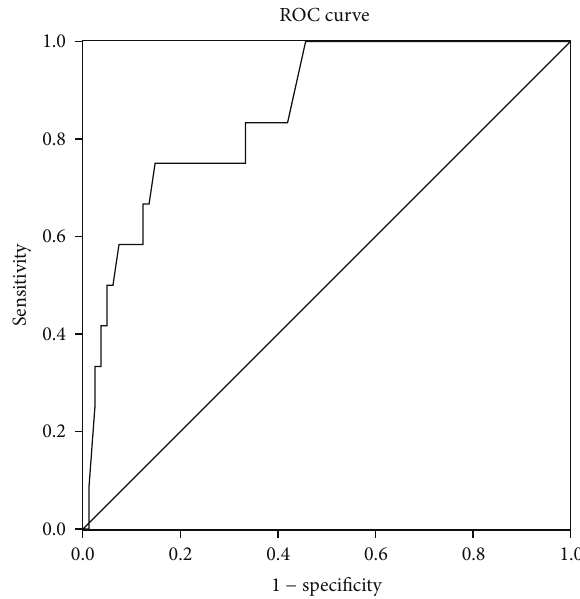
Figure 1: ROC curve for the prediction model. Diagonal segments are produced by